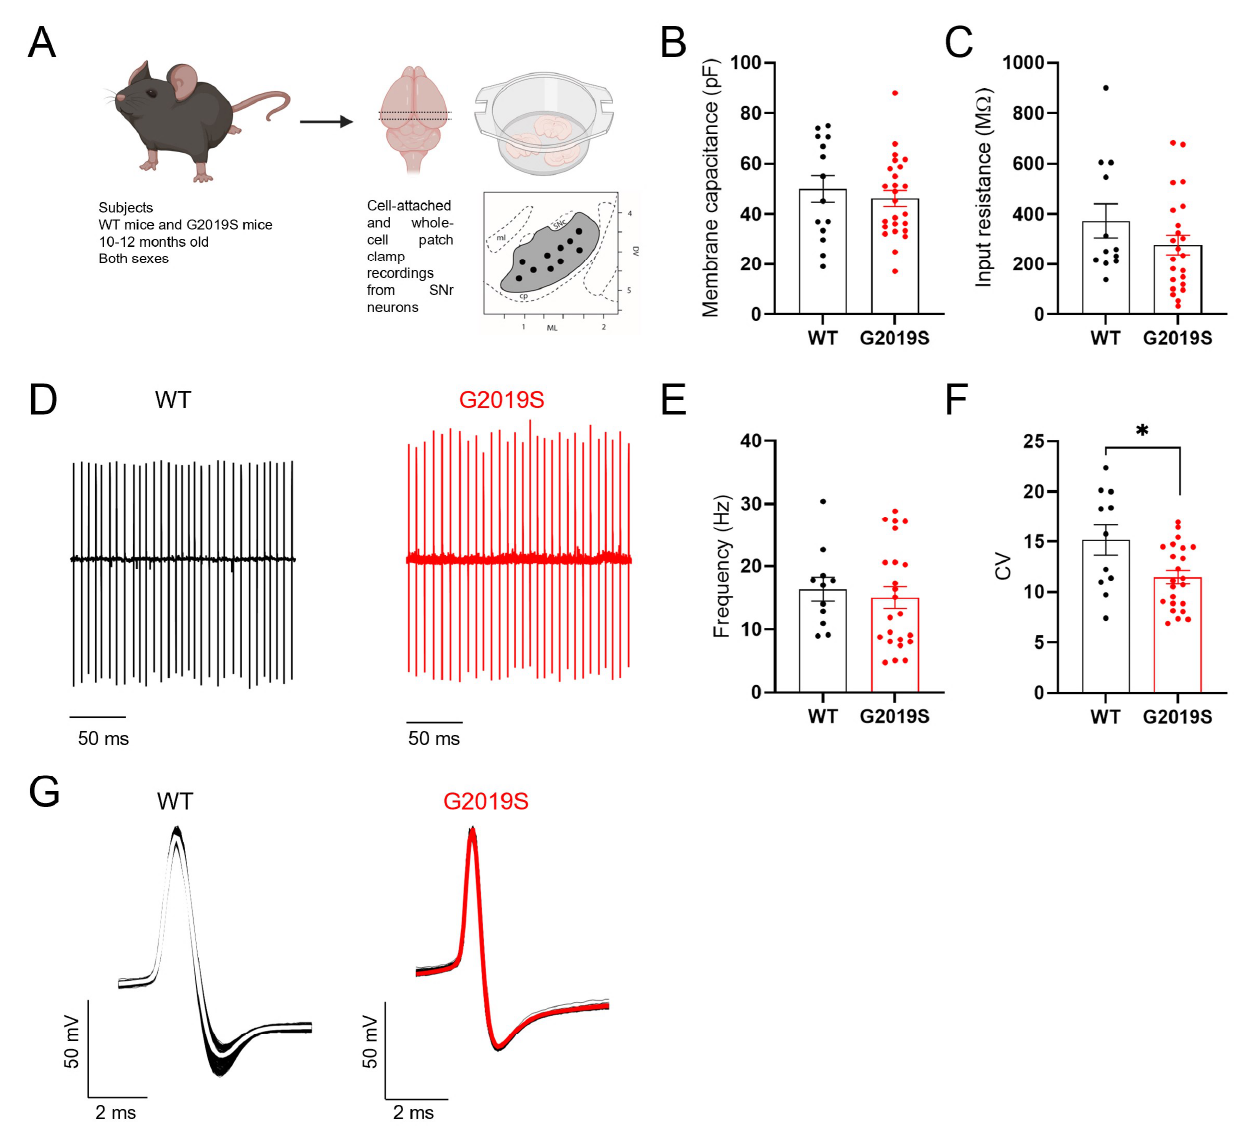
Figure 1. Intrinsic properties of SNr neurons. ( A ) Scheme illustrating the experimental model and the procedures. ( B , C ) No differences were found in the membrane capacitance ( B ) and input resistance ( C ) of SNr neurons between G2019S and WT mice (WT: n = 14 cells from N = 4 mice; G2019S: n = 25 cells from N = 9 mice). ( D ) Example traces of cell-attached recordings of the sponta- neous AP firing in SNr neurons from a WT mouse and a G2019S mouse. ( E ) The firing frequency of SNr neurons was similar in G2019S mice and WT mice (WT: 16.32 ± 1.9 Hz, n = 11 cells from N = 5 mice; G2019S: 15.02 ± 1.7 Hz, n = 23 cells from N = 6 mice; Mann-Whitney test p = 0.3827). ( F ) The coefficient of variation of the interspike intervals (CV) was significantly smaller in SNr neurons from G2019S mice compared to WT mice (WT: 15.0 ± 1.51, n = 11 cells from N = 5 mice; G2019S: 11.46 ± 0.65, n = 23 cells from N = 6 mice; unpaired t -test * p = 0.0130), indicating a more regular firing pattern. ( G ) Example traces of action potentials, measured in whole-cell current-clamp mode, in SNr neurons from a WT mouse and a G2019S mouse (see Table